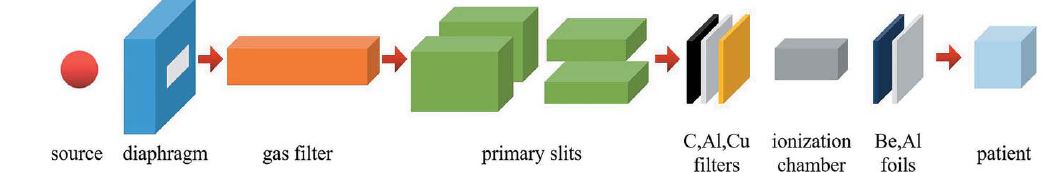
Figure 5 Beamline elements for the optimization